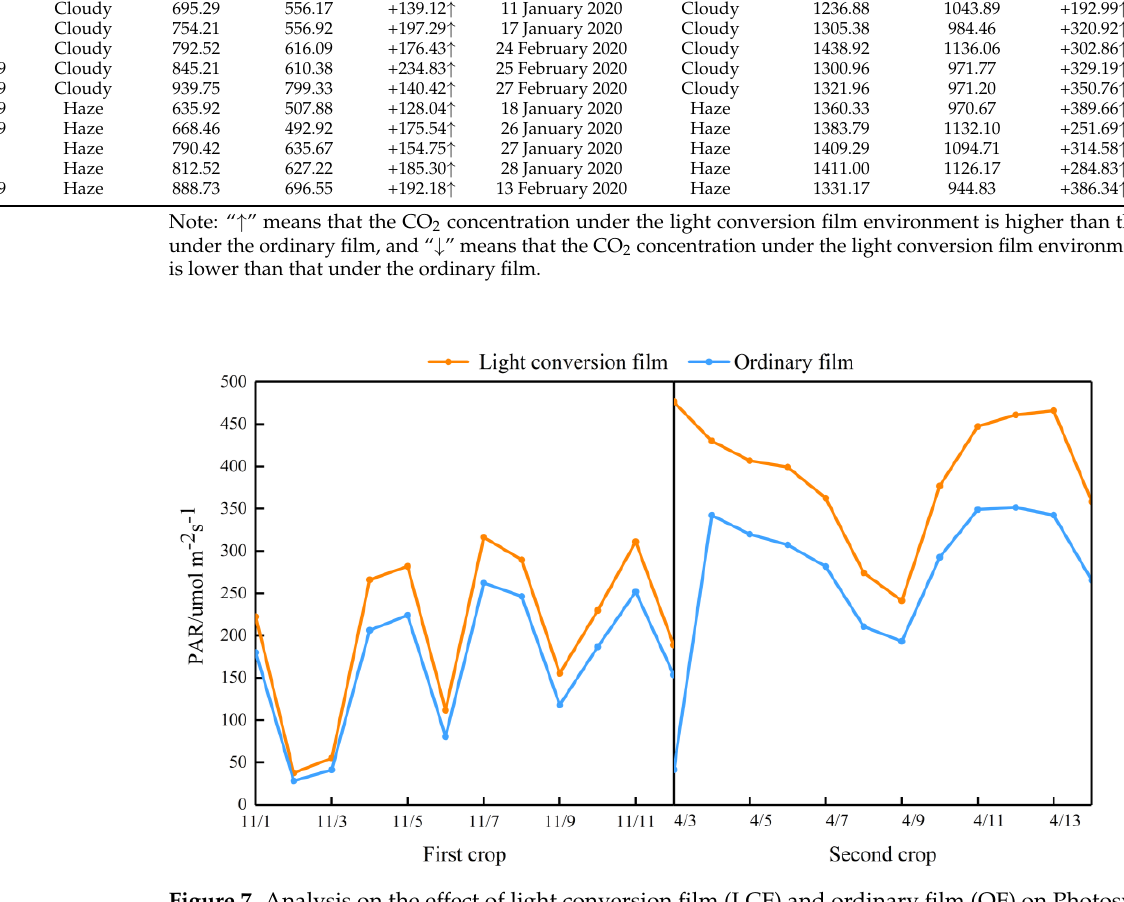
Figure 7. Analysis on the effect of light conversion film (LCF) and ordinary film (OF) on Photosyn- thetic effective radiation under different crops.